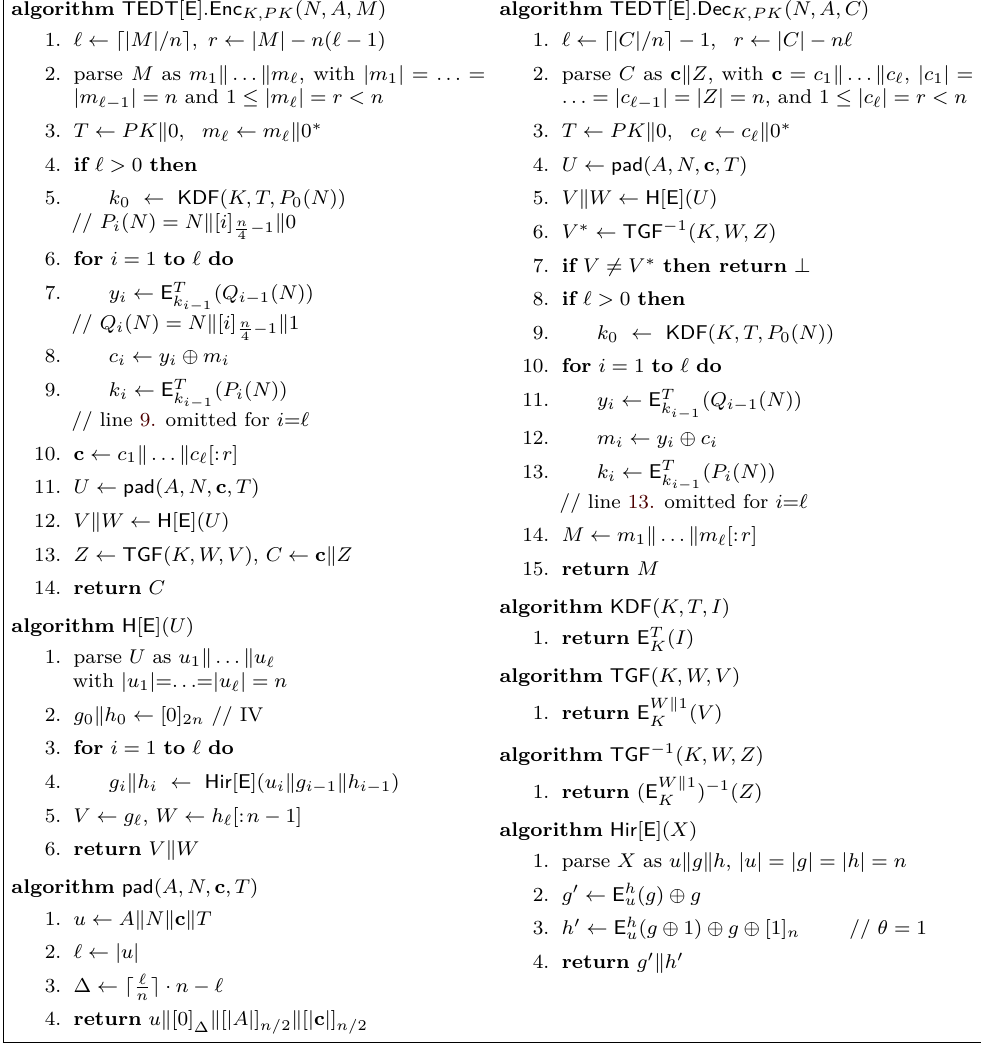
Figure 5: Definition of the TEDT mode, using a TBC E